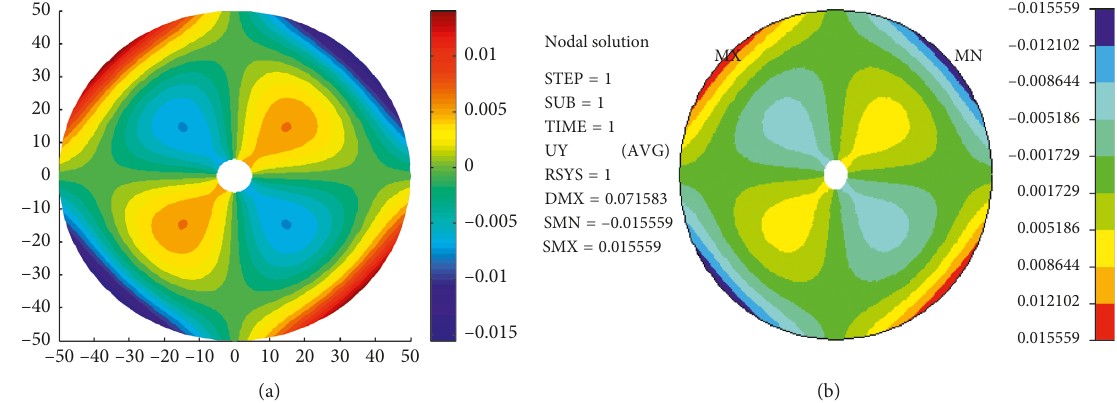
Figure 4: Cloud diagram of the circumferential displacements u